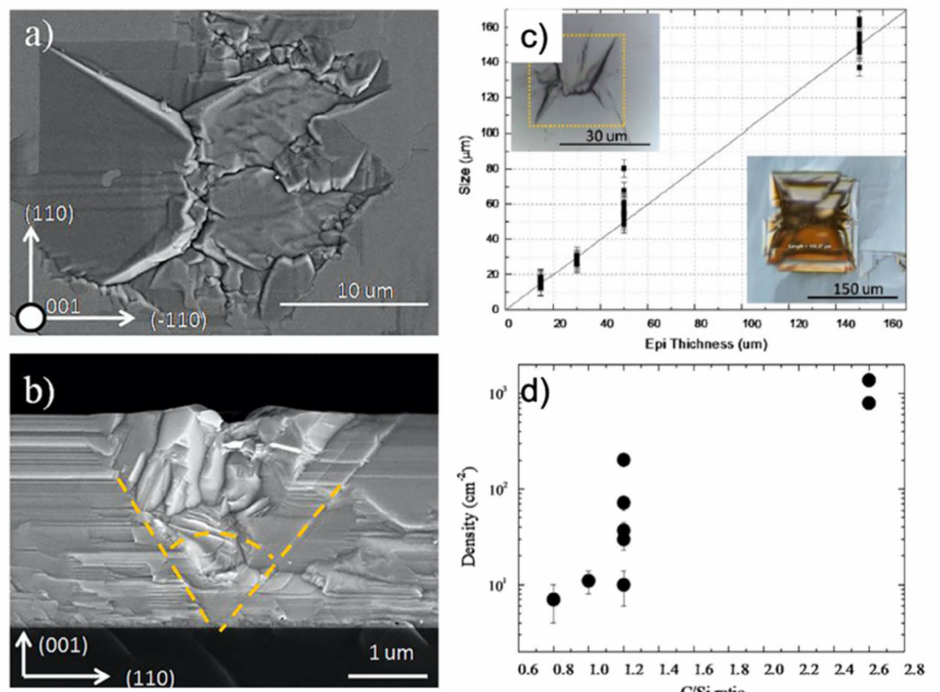
Figure 17. ( a ) Scanning electron microscope plan-view image of a protrusion in a 30 µ m-thick epitaxial layer. ( b ) Cross-view obtained after the cleavage of the wafer for a 3 µ m-thick epilayer. Yellow lines are drawn in order to identify the edge of the defect. Crystallographic orientations are also drawn. ( c ) The average size of the protrusions vs. the epitaxial layer thickness. ( d ) The density of the protrusion as a function of the C/Si ratio during the buffer layer step (adapted from Reference